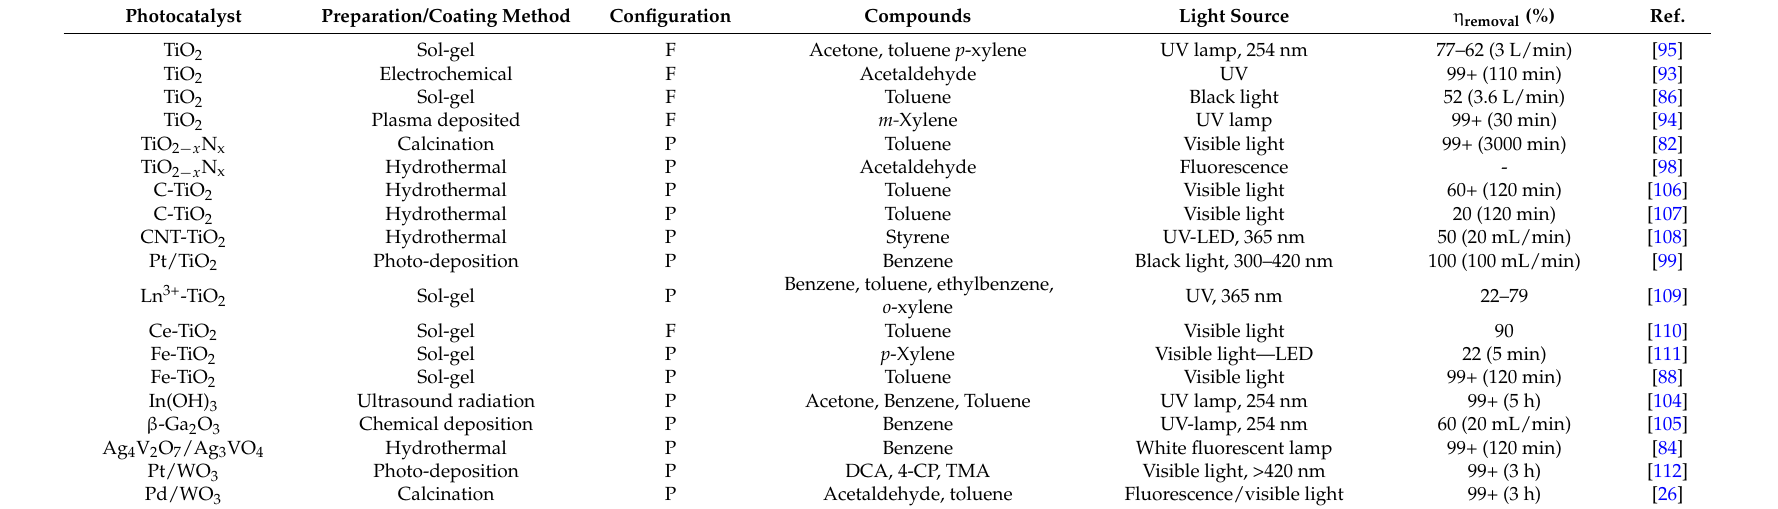
Table 4. Summary on potential photocatalysts applied for indoor VOCs